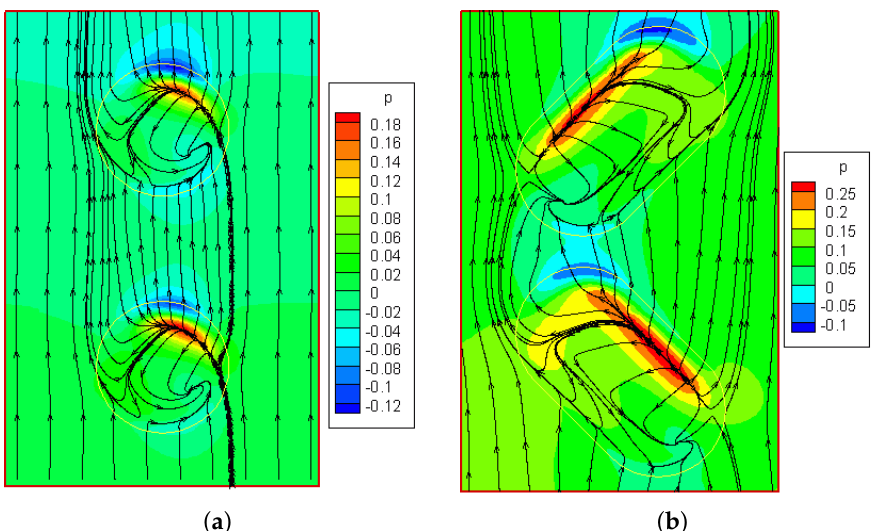
Figure 5. Comparison of patterns of coolant spreading along the wall with spherical ( a ) and oval ( b ) dimples with applied pressure fields.